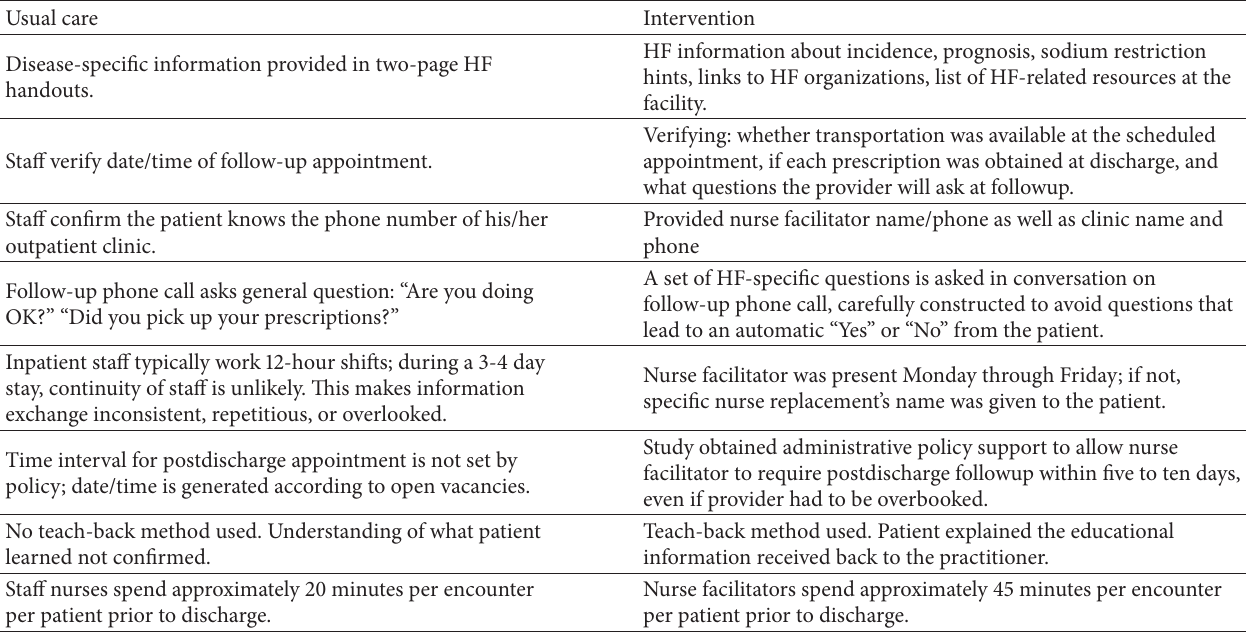
Table 1: Usual care versus intervention.